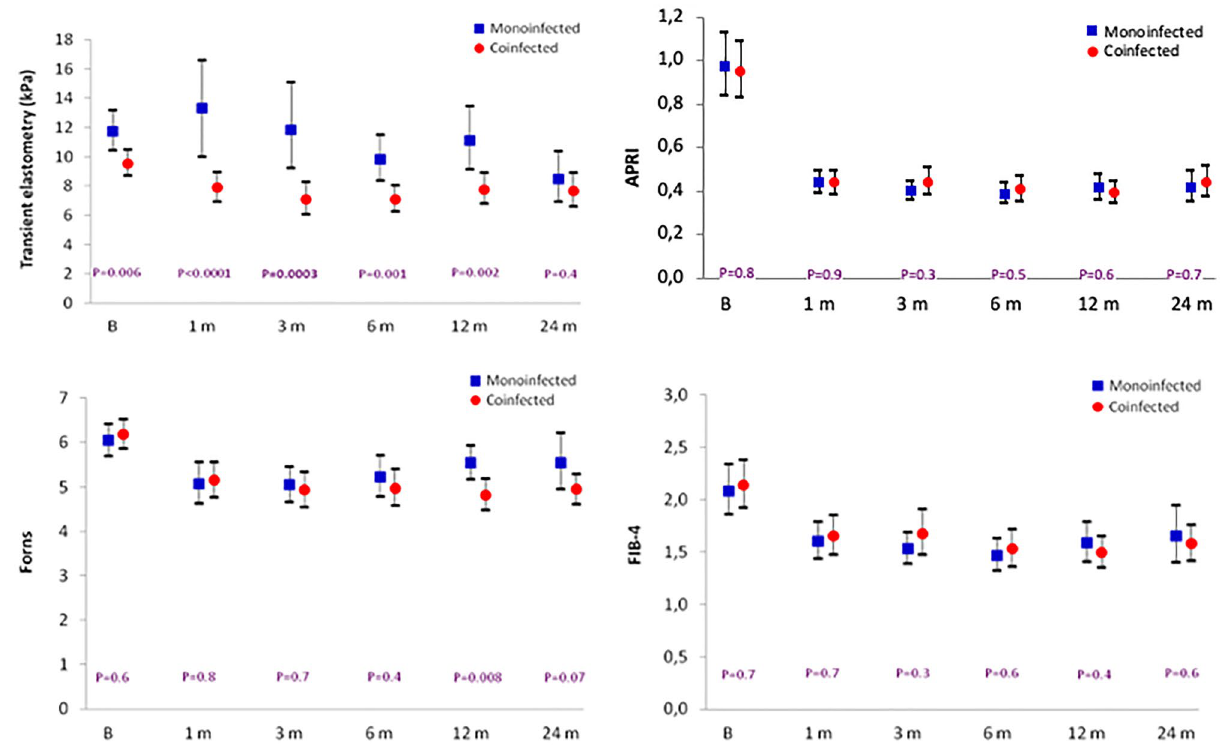
Figure 2. Course over time of the four fibrosis indexes in mono- and coinfected patients (mean, 95% CI).